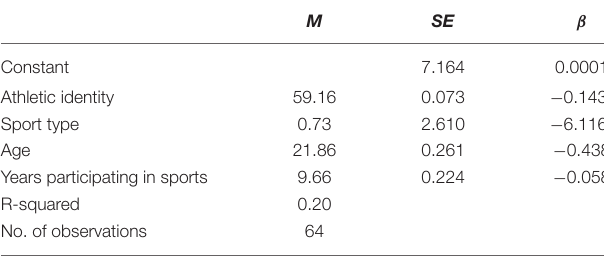
TABLE 4 | Regression result for psychological